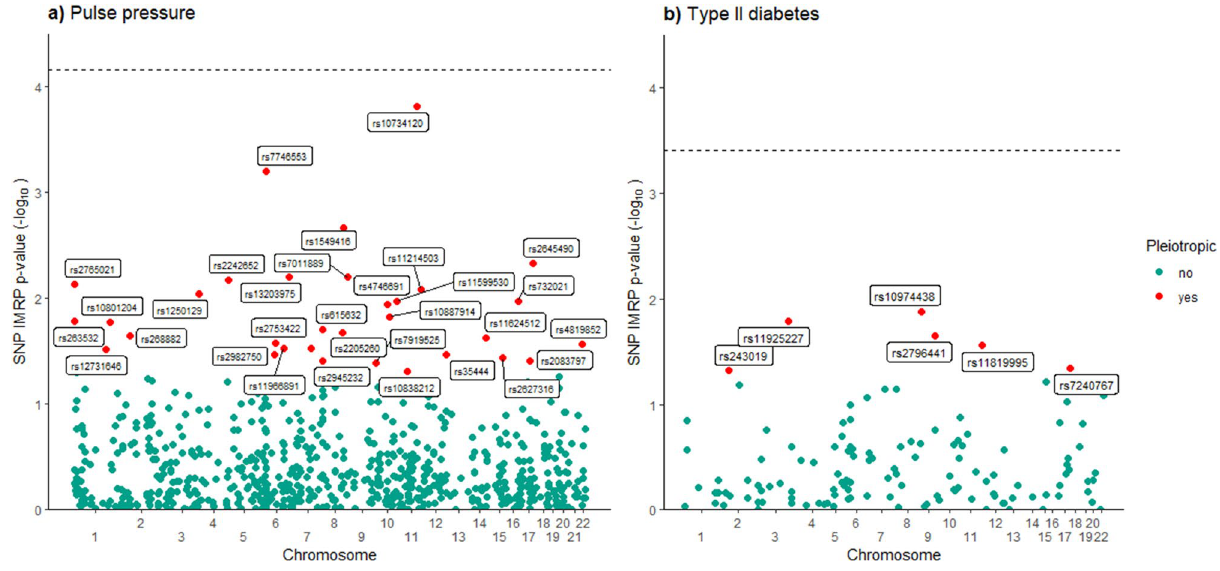
Figure 2. IMRP Pleitropy evidence—mixed ethnicity sample. Displayed are those SNPs demonstrating evidence of pleiotropic effects for pulse pressure and Type II Diabetes in the multi-ethnicity sample as estimated by IMRP. The horizontal dash line represents Bonferroni-adjusted Type I Error rate of p = 0.05.